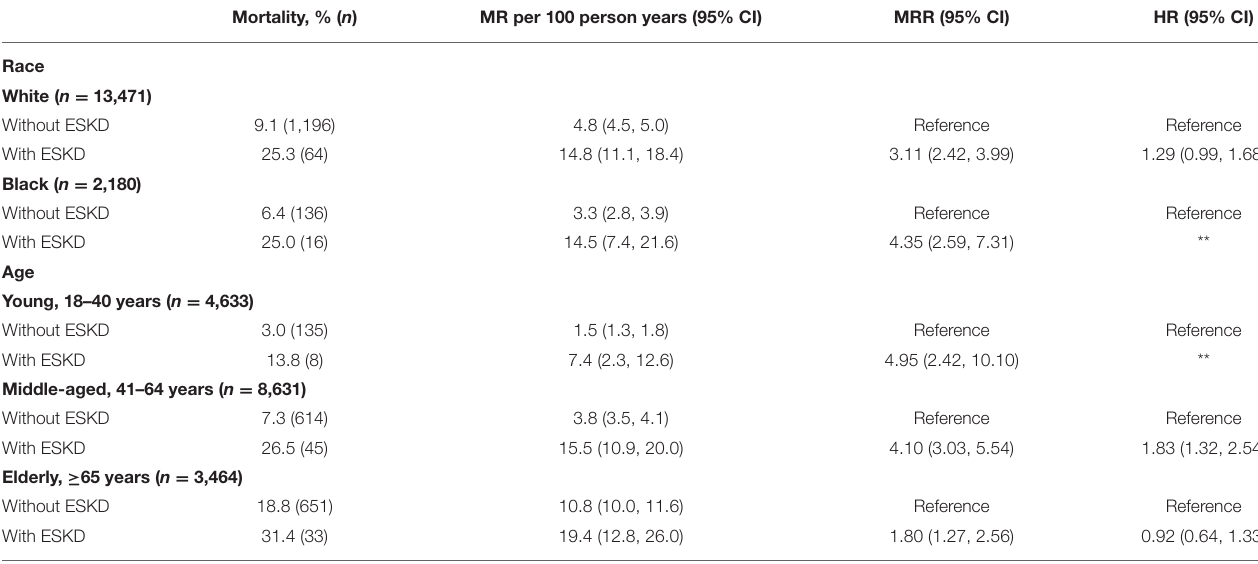
TABLE 3 | Mortality rate (MR), MR ratio (MRR), and adjusted hazard ratio (HR)* of mortality for those with and without end stage kidney disease (ESKD) by race and age group. Mortality, % ( n